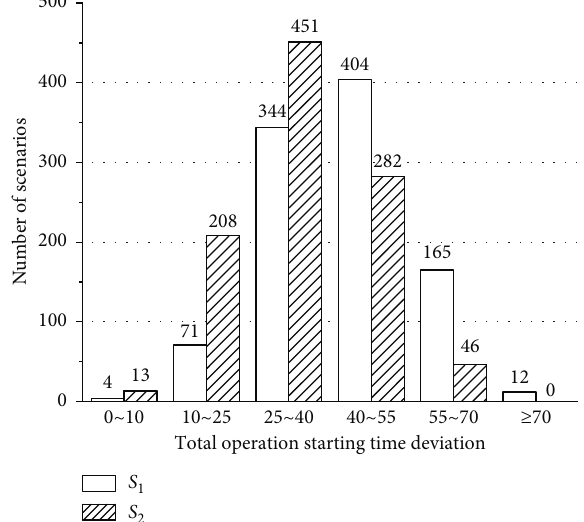
Figure 5: Distribution of total operation starting time deviation for 1000 scenarios.